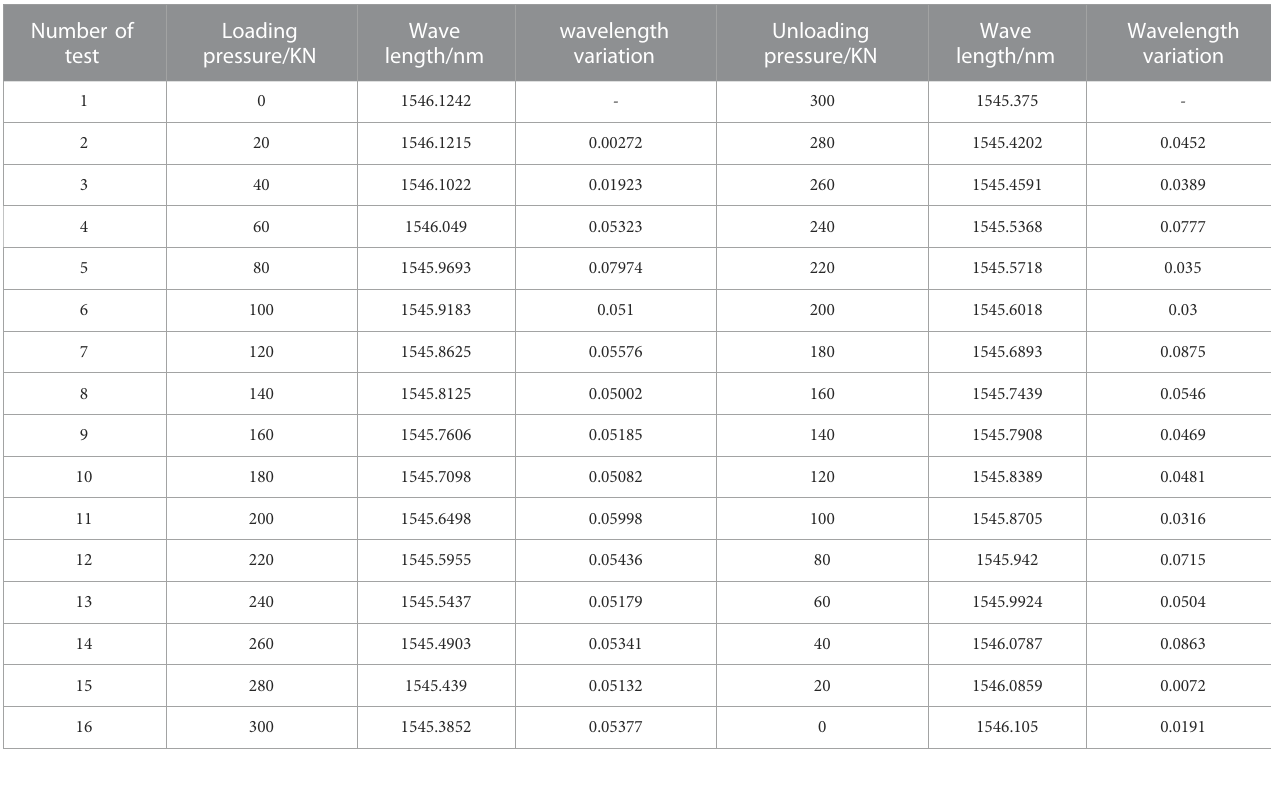
TABLE 3 Experimental data for the performance test of the CS-FBG borehole stress meter.